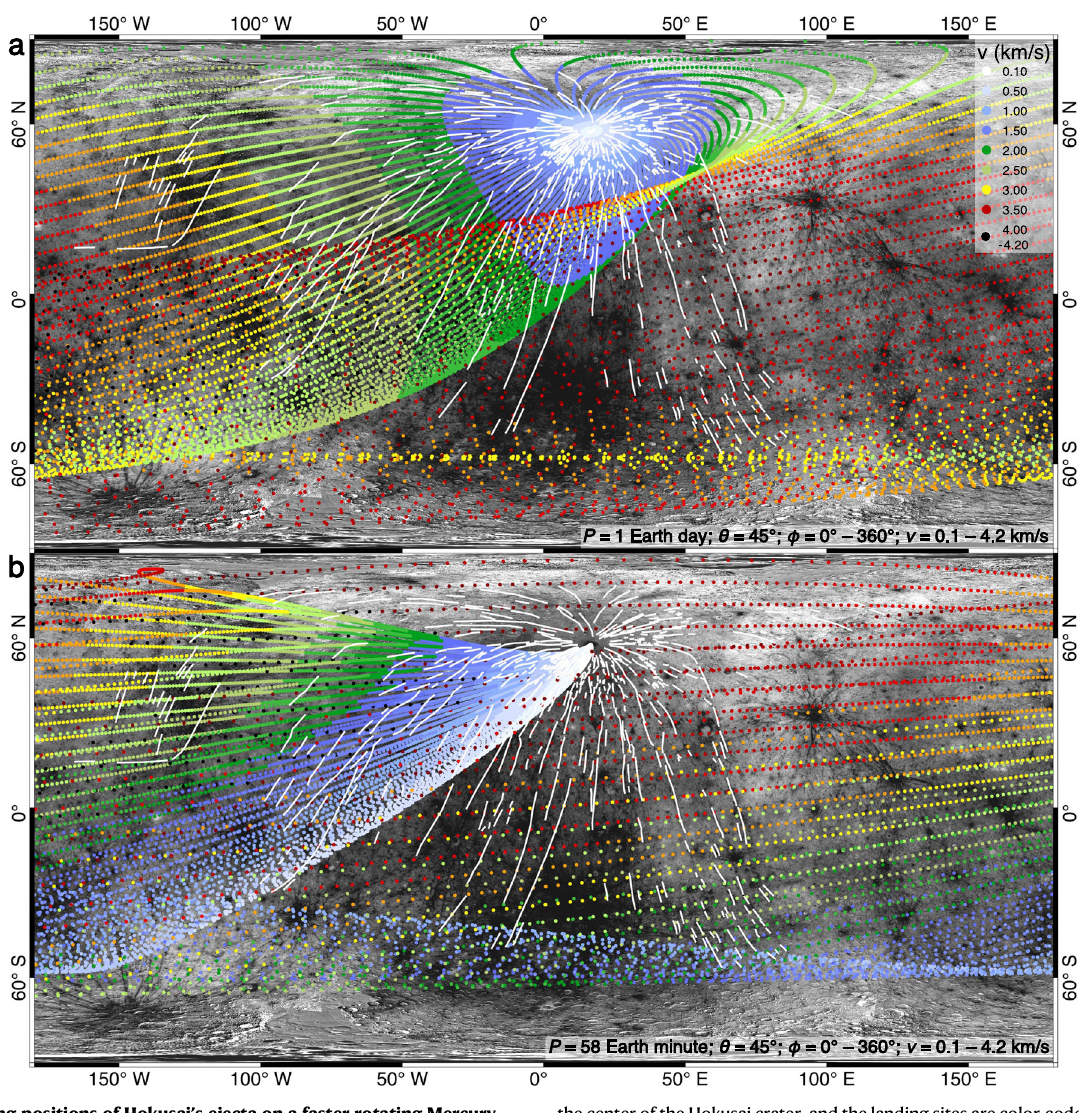
Fig. 5 | Landing positions of Hokusai ’ s ejecta on a faster rotating